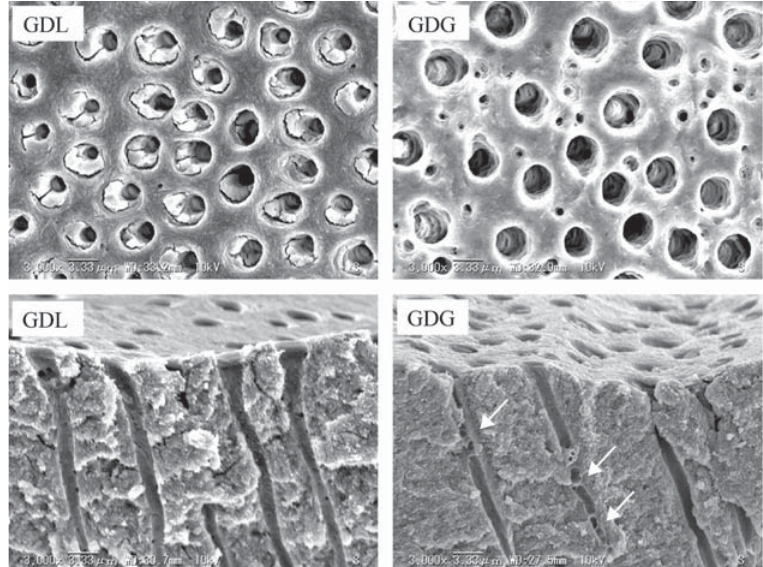
Figure 5- Representative scanning electron microscope micrographs (3,000x) of GDL and GDG treated dentin disc surfaces and of samples fractured perpendicular through the desensitizer-treated surfaces after rinsing with water. The morphologies of the treated surfaces are similar; no remnants of the thickening agent of GDG on free surface or inside tubules. In two of the longitudinally exposed tubules of GDG transverse septa are displayed